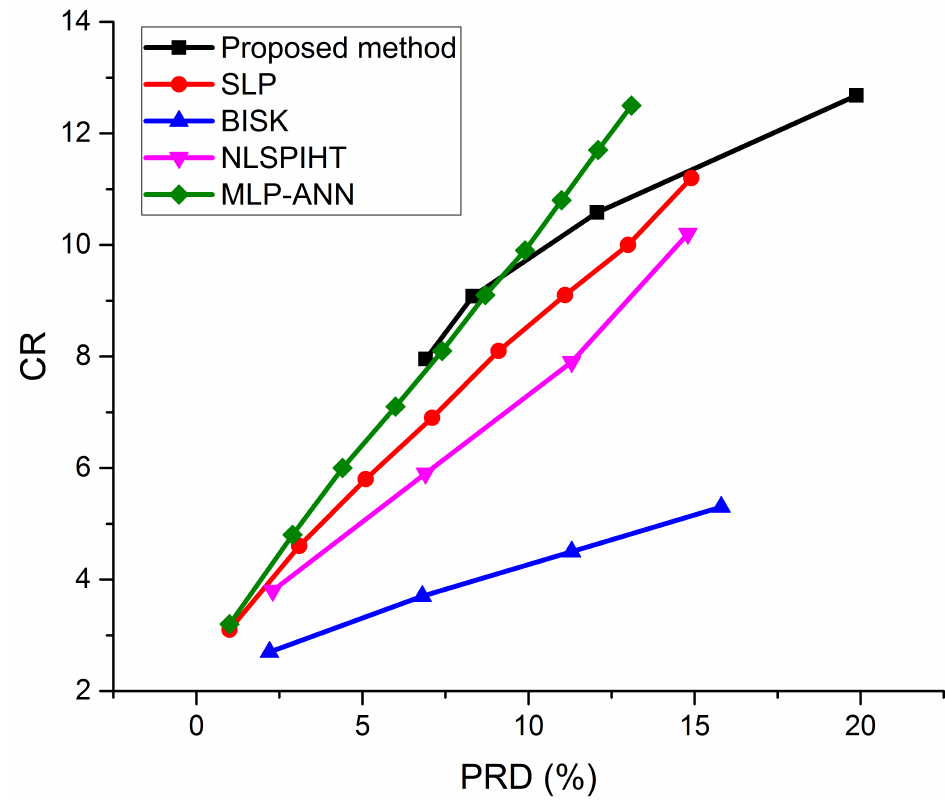
Figure 8. Comparison of the proposed method with SLP, BISK, NLSPIHT, and